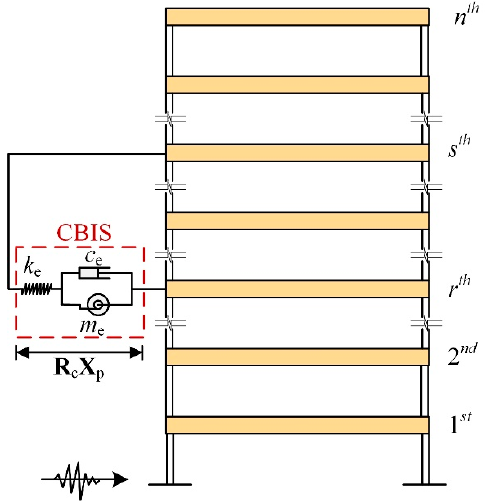
Figure 5. Schematic of an multi-degree-of-freedom (MDOF) structure with a CBIS.